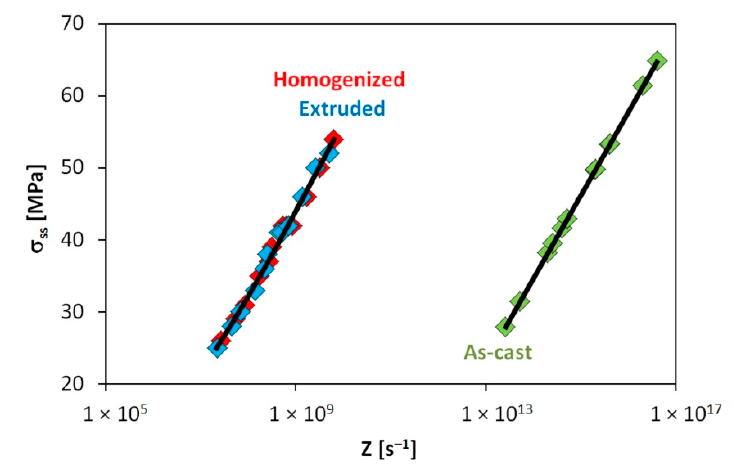
Figure 12. Dependence of measured and calculated values of σ ss on the Zener-Hollomon parameter and the initial structural state.